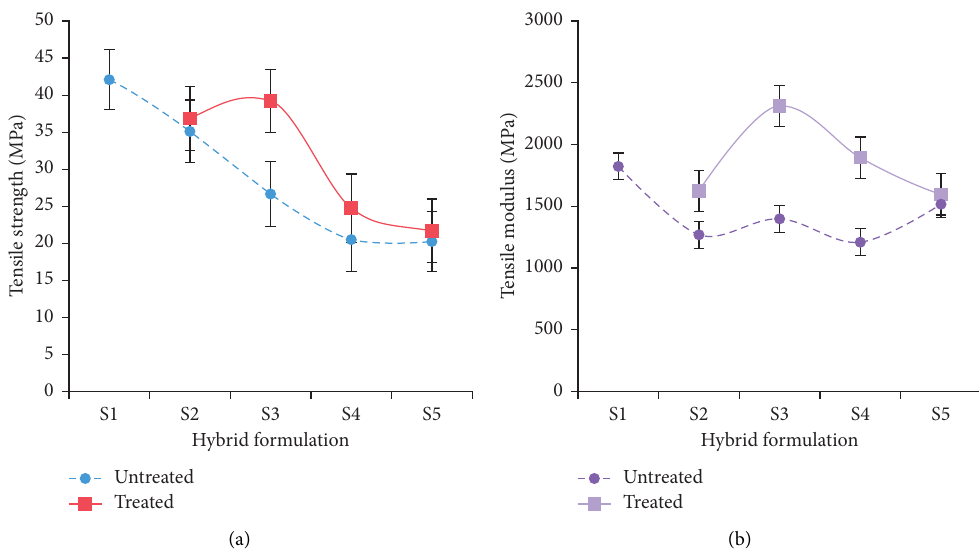
Figure 3: Effect of alkali treatment on (a) tensile strength and (b) tensile modulus of glass/kenaf fibre hybrid composites Table 6: Effect of natural fibre chemical pretreatment on physical and mechanical properties of resultant hybrid composites. Hybrid Chemical pretreatment Effects of pretreatment Reference composite